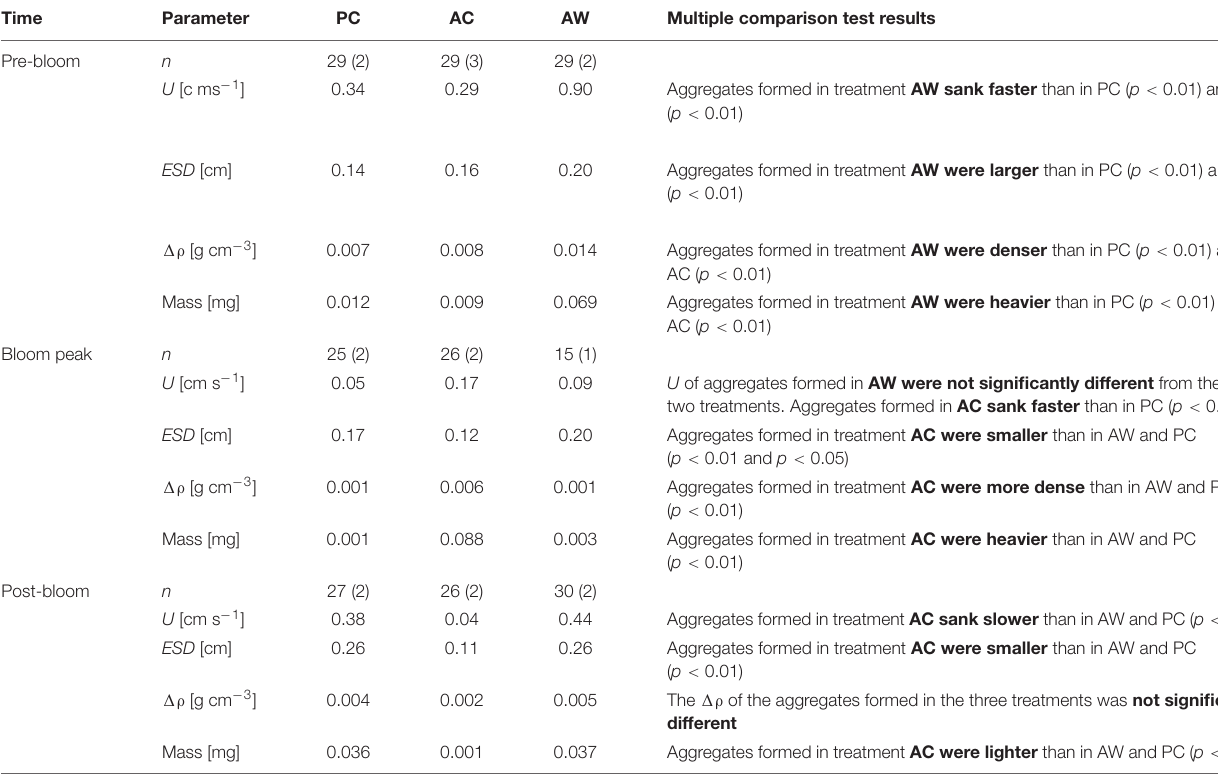
TABLE 1 | Median and results of the Kruskal–Wallis test with posterior multiple comparisons analysis for the RTEs. Time Multiple comparison test